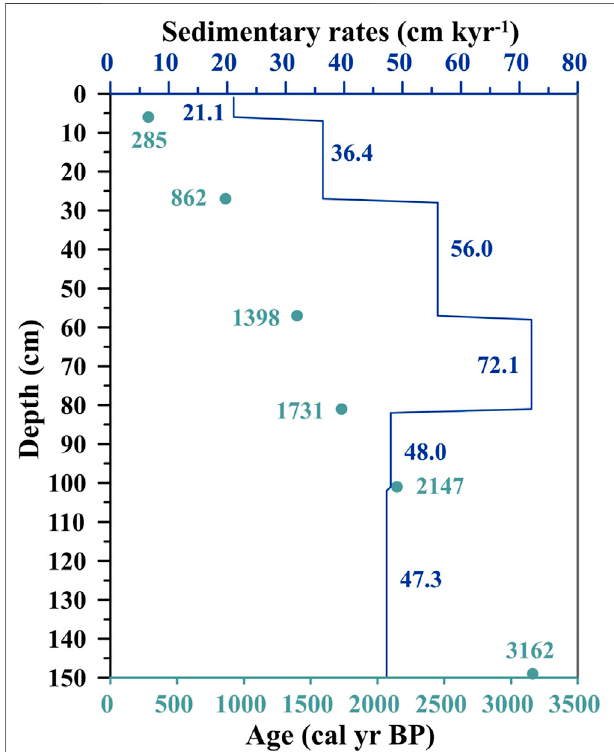
FIGURE 2 | Plots of Depth vs. Age and Sedimentary rates from core